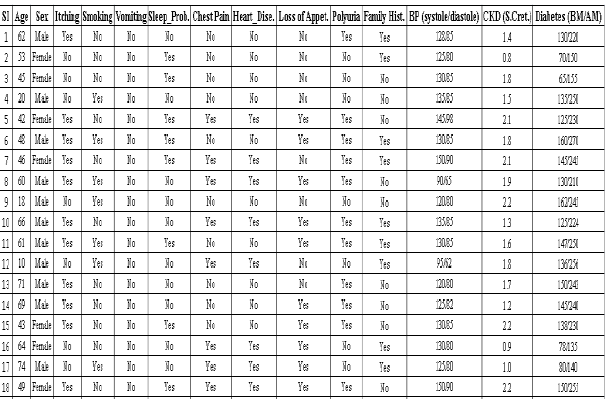
Table 9. Sample dataset of diabetic nephropathy